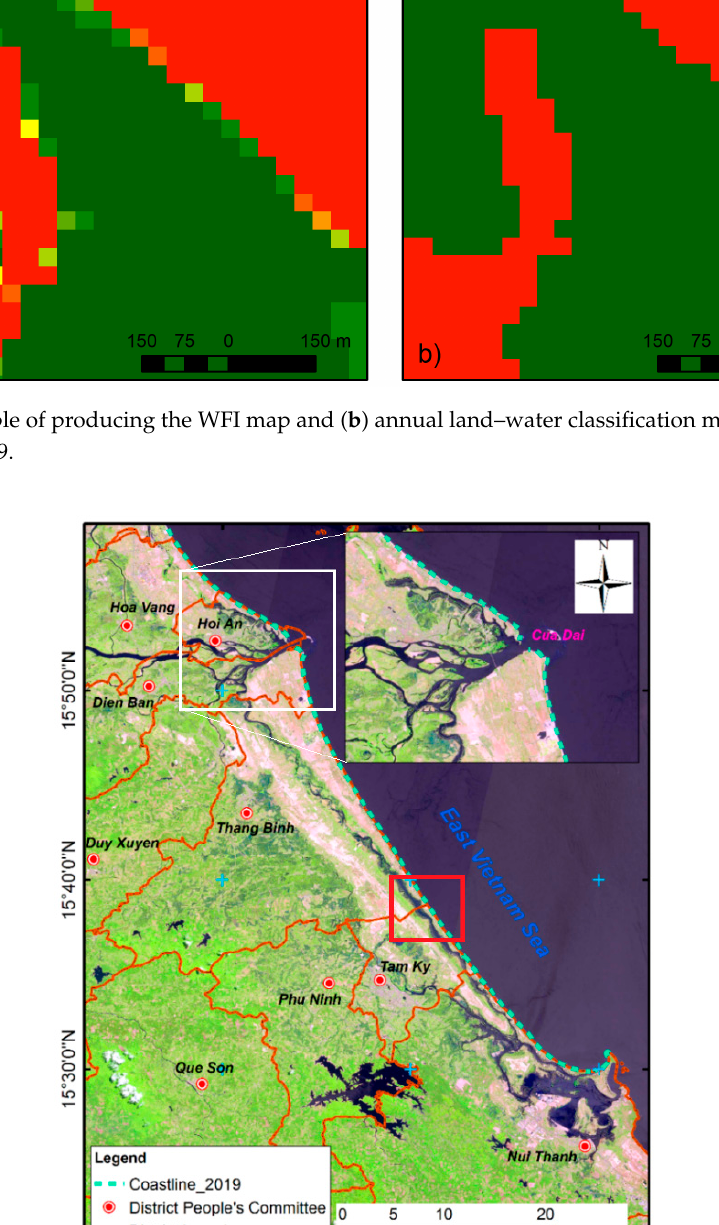
Figure 8. The annual coastline of Quang Nam province in 2019.